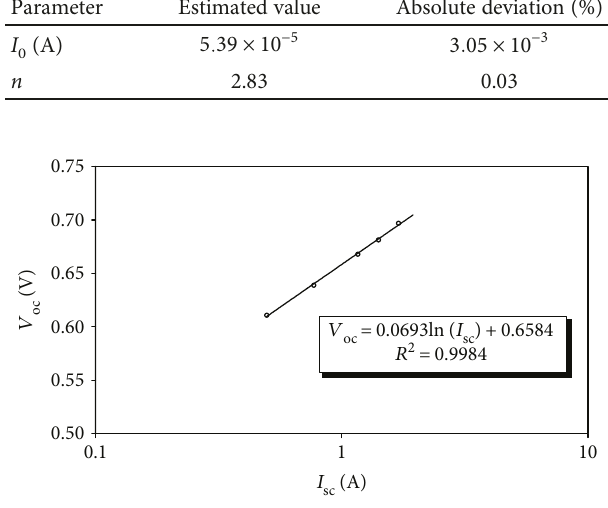
Figure 8: V and I measured (symbols) at di ff erent irradiance oc sc levels. The solid line is a linear fi